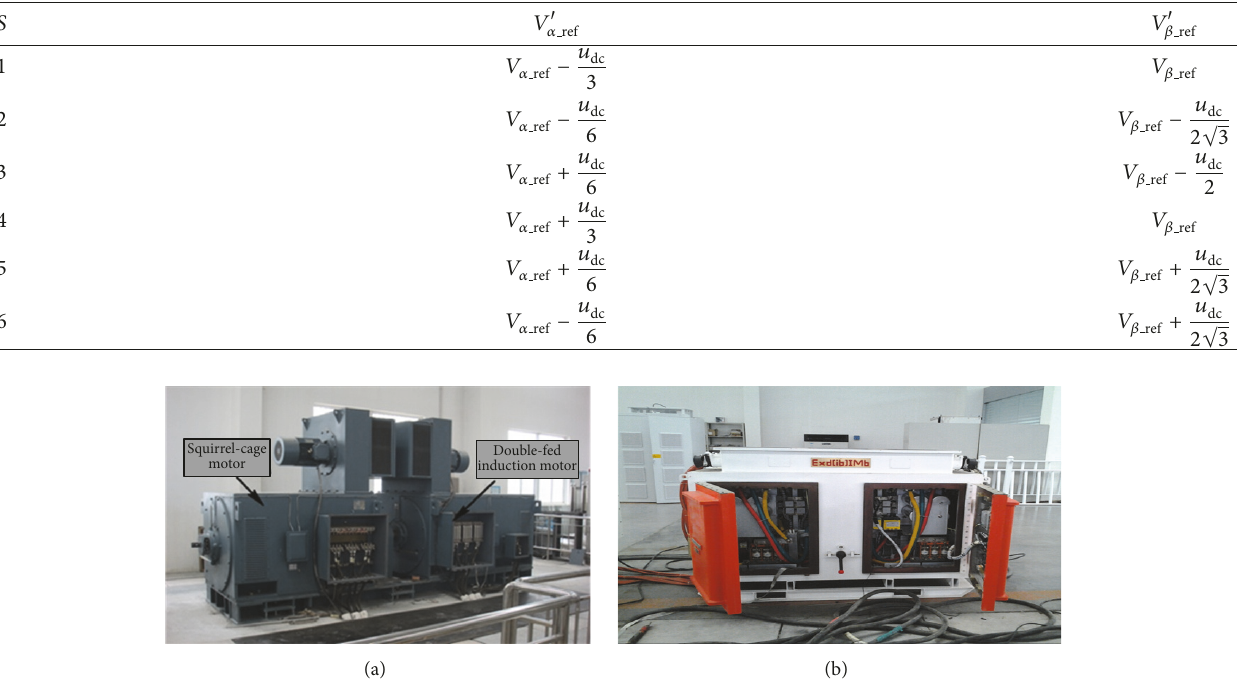
Figure 7: Experiment platform. (a) Motor part; (b) inverter part.